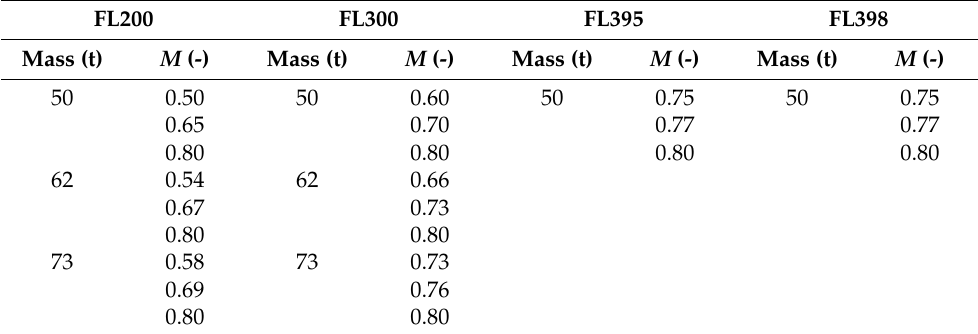
Table 1. The overall maximum circulation obtained in this analysis from Sarpkaya’s model, at horizontal separation of 3 and 5 NM, was 593 and 578 m 2 /s at FL200, 726 and 708 m 2 /s at FL300, and 745 and 726 m 2 /s at FL395, corresponding to the A380-861 as generator aircraft (the results at FL398 are not shown as they are very close to FL395). As expected, for the reasons explained before, the obtained maximum WV circulations increase with altitude. Table 2. Realistic flight operation conditions for the A320-212 at FL200, FL300, FL395, and FL398.